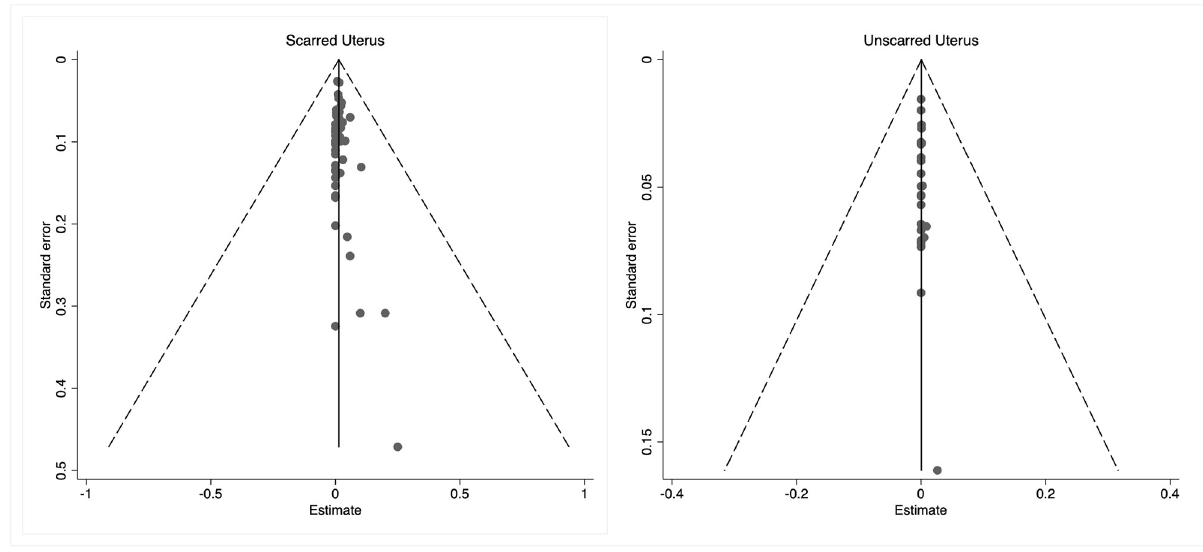
Fig 4. Publication bias of the included